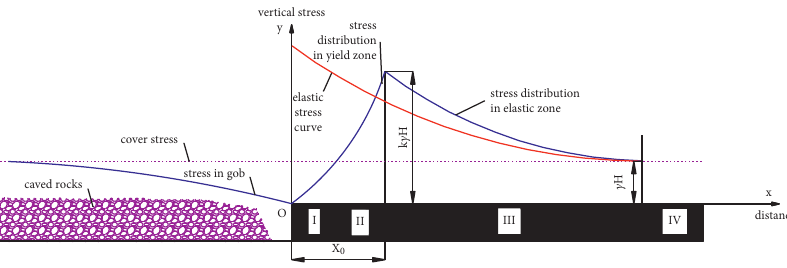
Figure 2: Stress redistribution due to coal excavation using CLL [13].